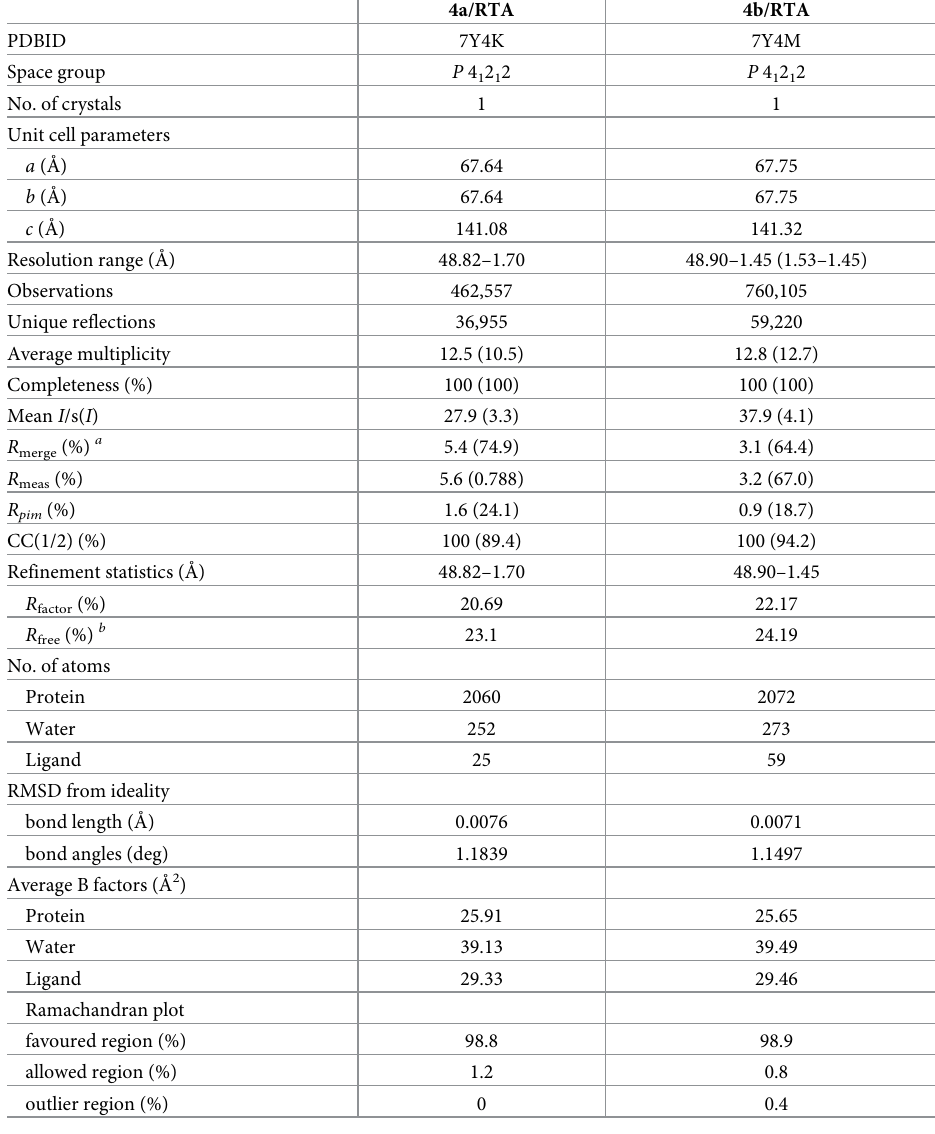
† Values in parentheses correspond to values of the highest resolution shell. a R merge = S hkl S i | I hkl,i – < I hkl > | / S hkl S i I hkl,i , where I = observed intensity and < I > = average intensity for multiple measurements. b R free was monitored with 5% of the reflection data excluded from the